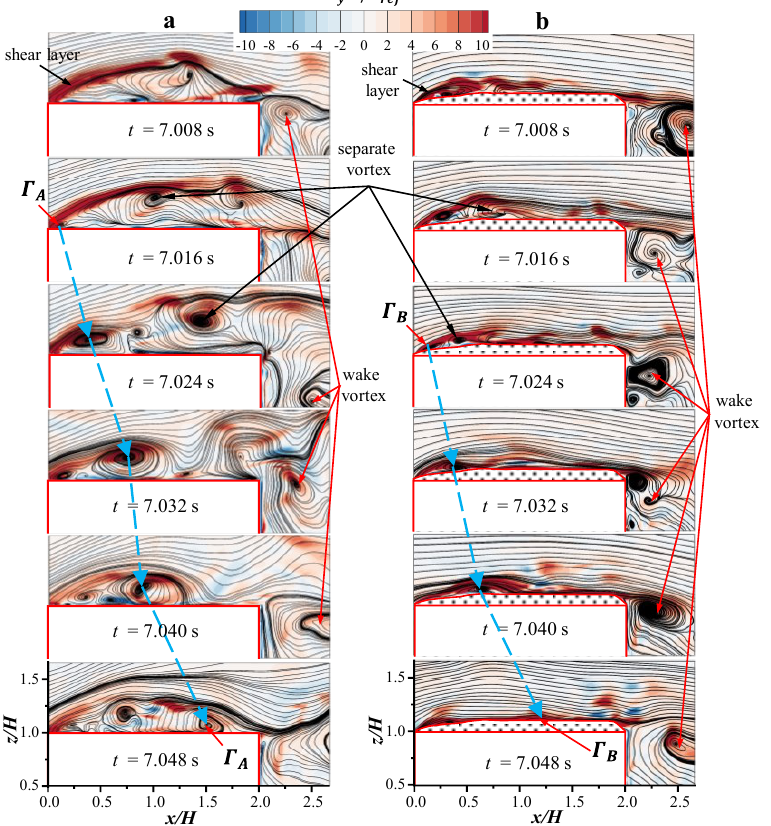
Figure 10. Comparison of instantaneous flow evolution between ( a ) No_snow and ( b ) Snowdrift case for M2.